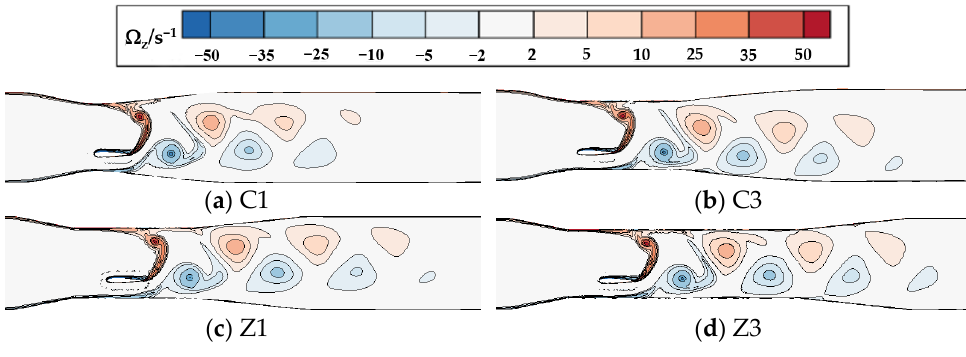
Figure 14. Vorticity cloud chart with different flow passage structure.